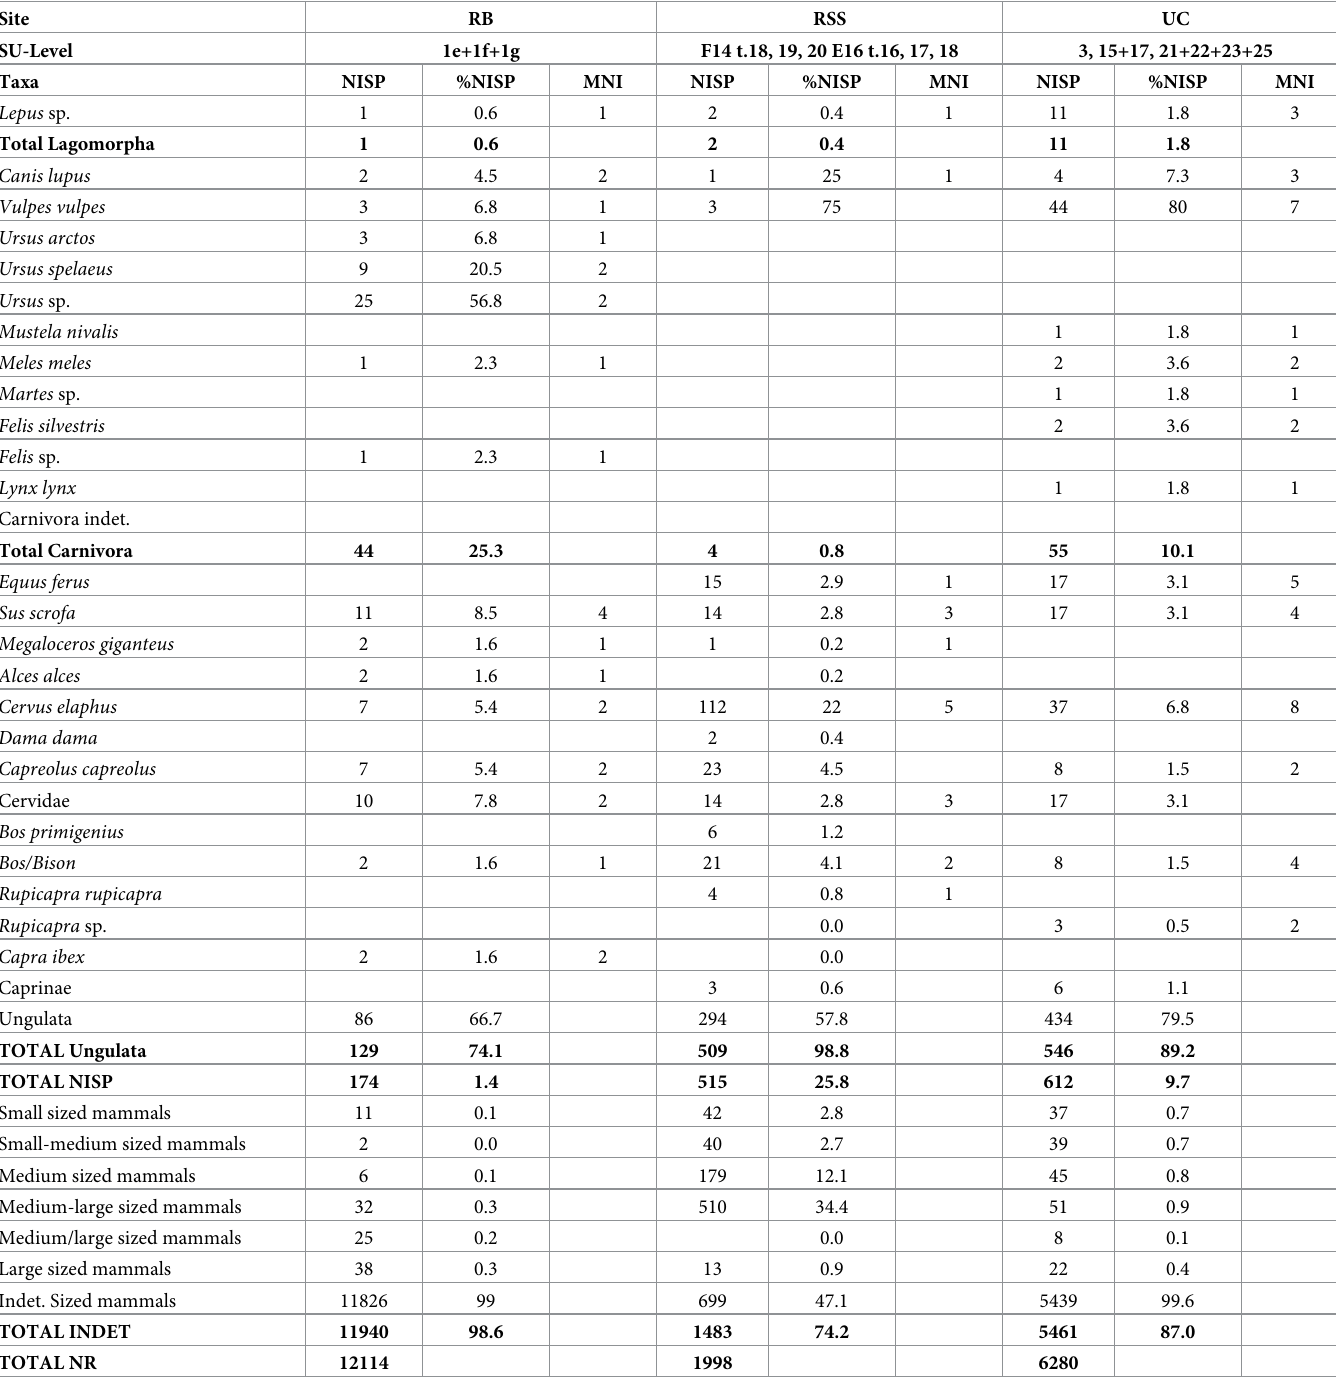
Table 1. Mammals NISP (Number of Identified Specimens), %NISP and MNI (Minimum Number of Individuals) for the analysed contexts. RB (Riparo del Broion), RSS (Roccia San Sebastiano cave) and UC (Uluzzo C Rock Shelter).